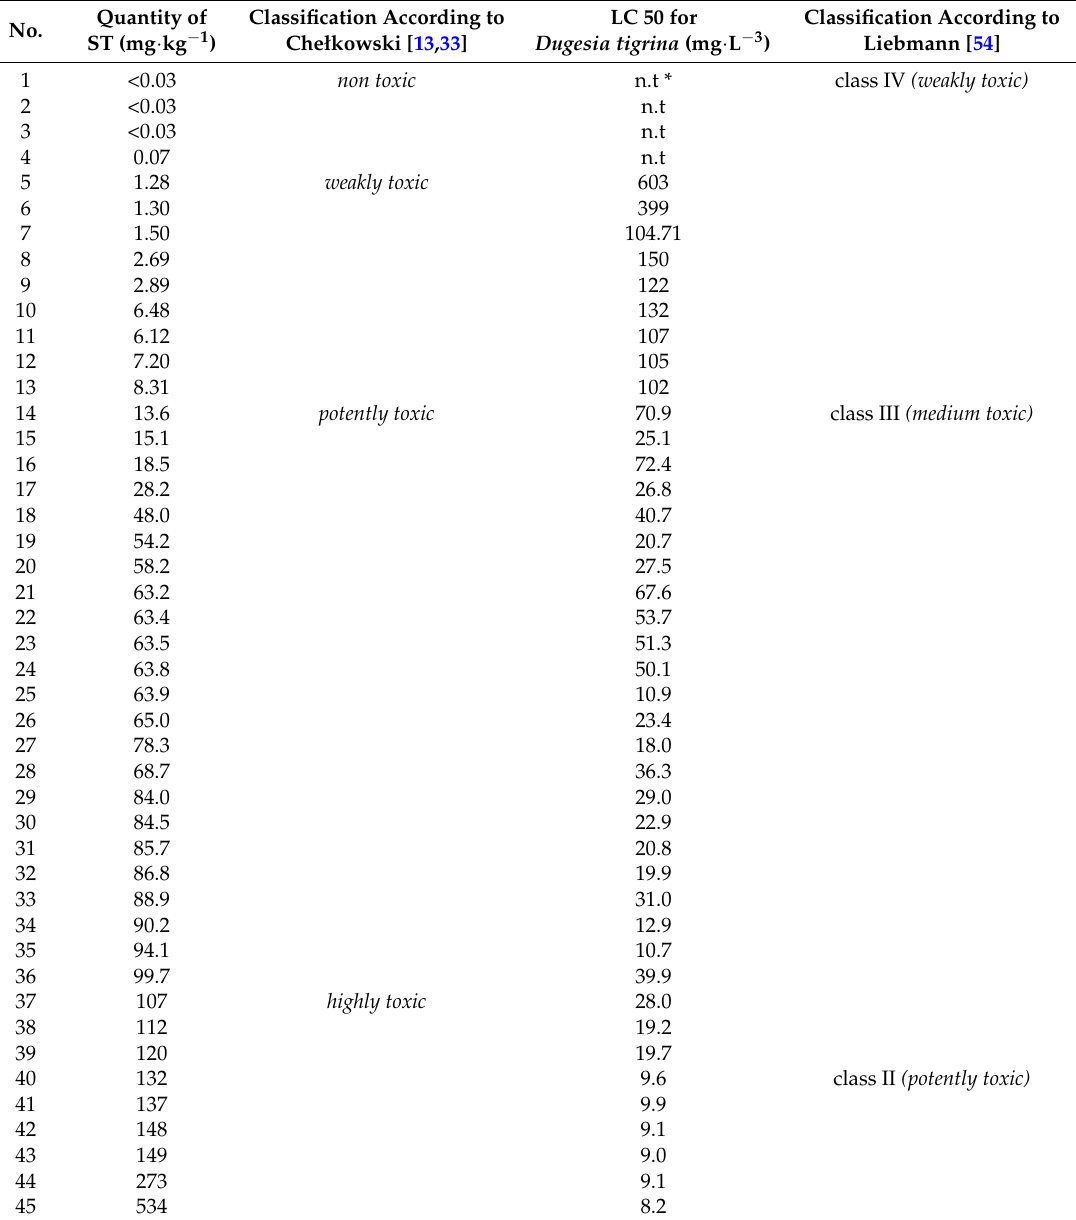
Table 4. Specification of the results of toxicological tests from biomasses of A. versicolor